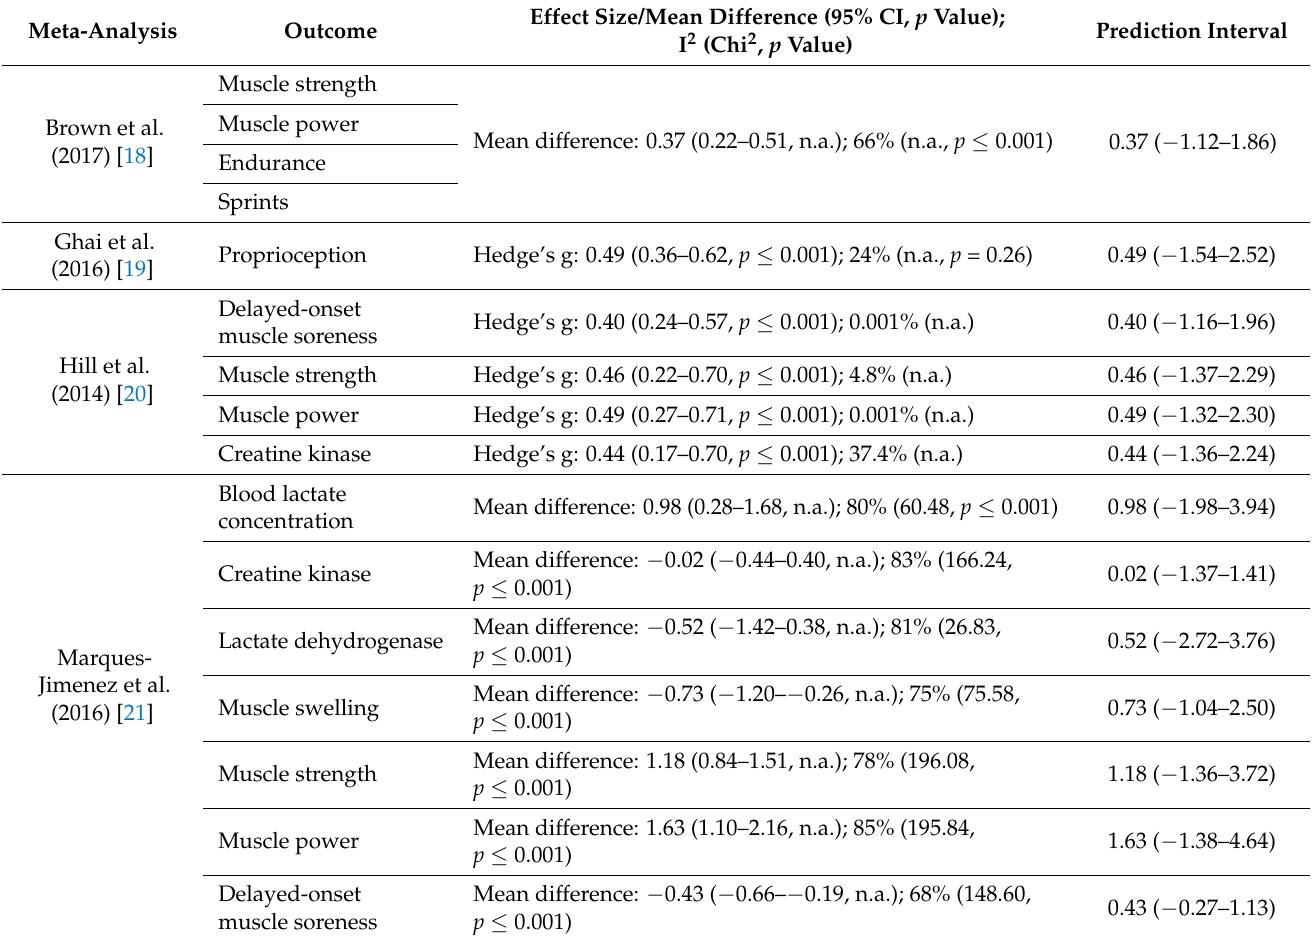
Table 4. Included meta-analyses that examined the effects of smart compression garments on physiological outcomes in healthy